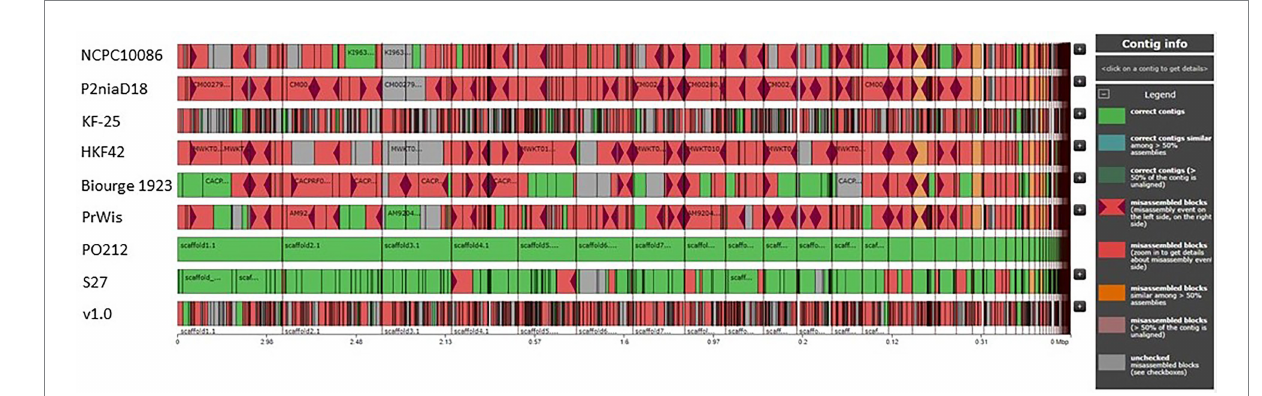
FIGURE 2 Comparative graphs of P2niaD18, PrWis, Biourge 1923, NCPC10086, KF-25, HKF42, v1.0, S27, and PO212 genomes. Contig alignment viewer, showing the organization of the genomes with reference to PO212. Green regions are right contigs, blue regions are correct contigs similar among >50% assemblies, and in dark green are the contigs referring to correct contigs (>50% of the contigs are unaligned). Pink regions with garnet triangles refer to misassembled blocks (misassemblies events on the left side or the right side), whole pink regions refer to misassembled blocks, orange regions are misassembled blocks (similar among >50% assemblies), brown regions are misassembled blocks (>50% of the contigs are unaligned), and gray regions are unchecked misassembled blocks (Visualized with